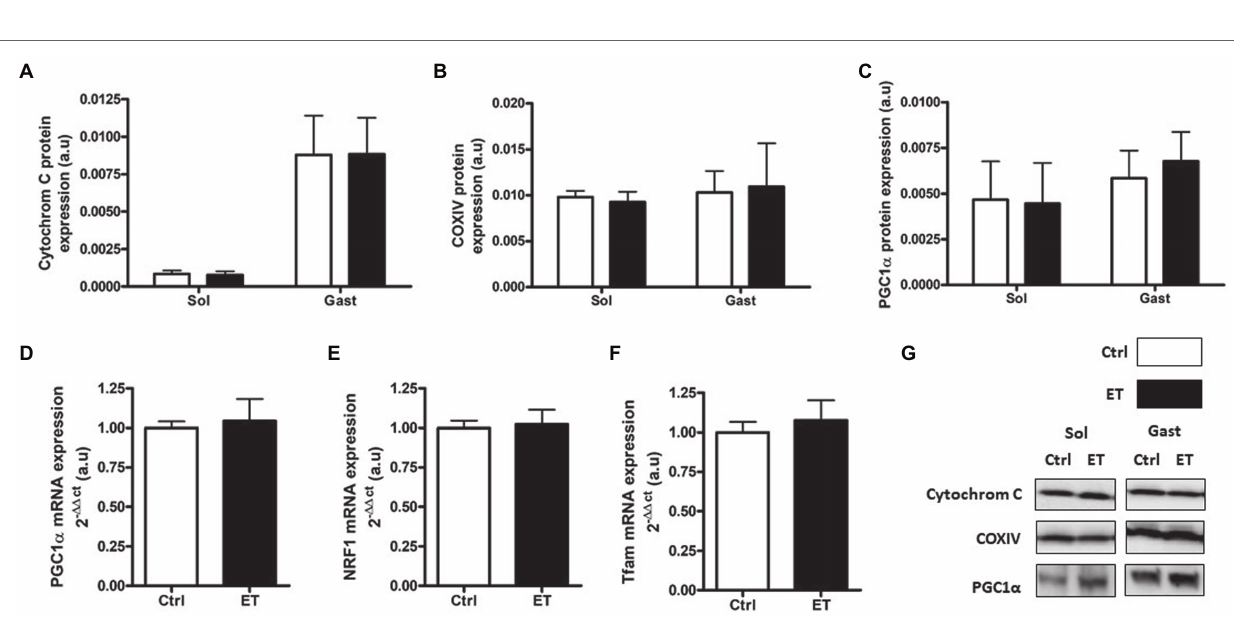
FIGURE 11 | Ergothioneine effect on mitochondrial markers 2 h after exercise. Mitochondrial markers. (A) Cytochrome C protein expression. (B) COX IV protein expression. (C) PGC1a protein expression. (D) PGC1a mRNA level. (E) NRF1 mRNA level. (F) Tfam mRNA level. (G) Representative Western Blots; * p < 0.05 vs.